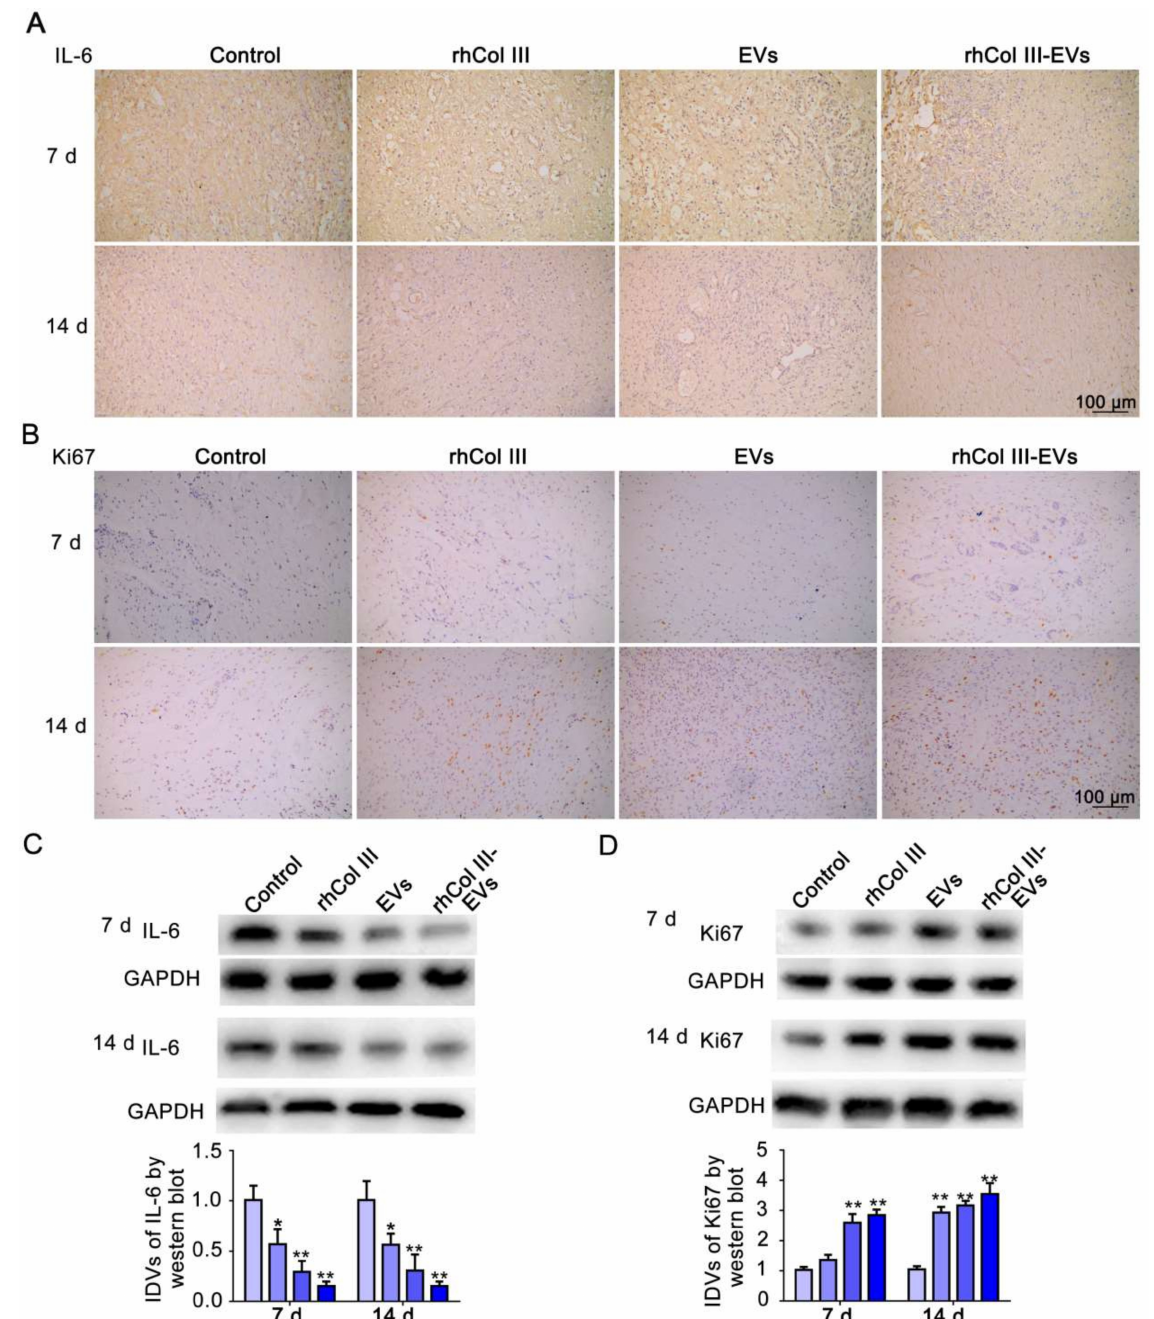
Figure 6. Expression analysis of IL-6 and Ki67 in wound tissue. ( A ) Immunohistochemistry images for IL-6 at 7 and 14 days. ( B ) Immunohistochemistry images for Ki67 at 7 and 14 days. ( C ) Western blot for IL-6 at 7 and 14 days ( n = 3, * p -value < 0.05 vs. Control group, ** p -value < 0.01 vs. Control group). ( D ) Western blot for Ki67 at 7 and 14 days ( n = 3, * p -value < 0.05 vs. Control group, ** p -value < 0.01 vs. Control